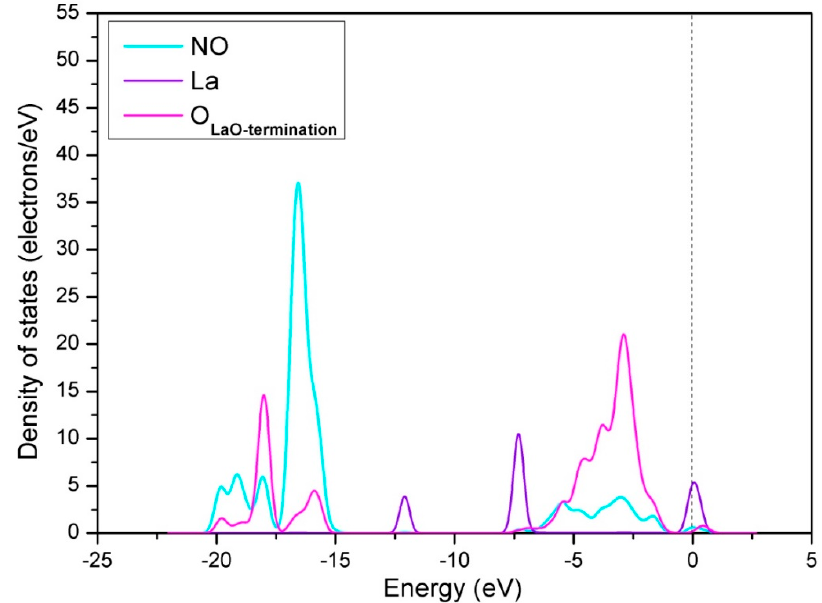
Figure 5. Density of states of adsorbed NO molecule, La and O atoms on the surface when NO is adsorbed on the perfect LaO-terminated LaCoO 3 (011) surface with hollow-NO